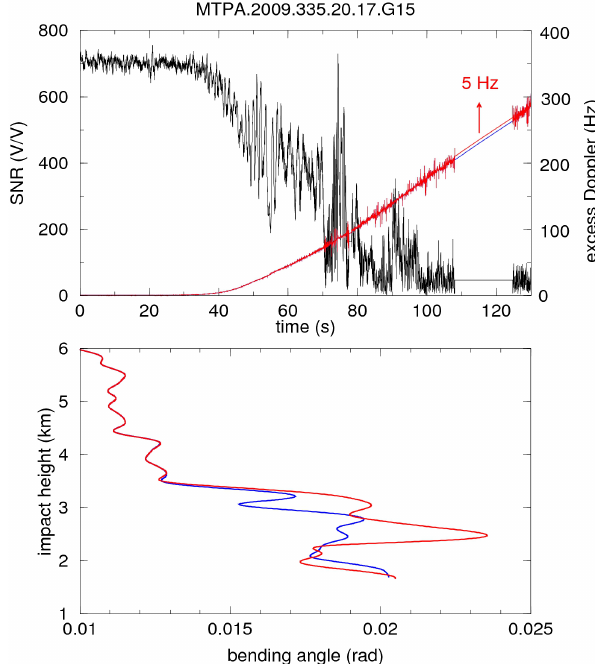
Fig. 23. An example of Metop/GRAS occultation with data gap. Upper panel: SNR and excess Doppler filled with the model in- side the gap. Lower panel: retrieved bending angles. Shifting the Doppler model inside the gap by 5Hz (upper panel) results in the difference in retrieved bending angles (lower